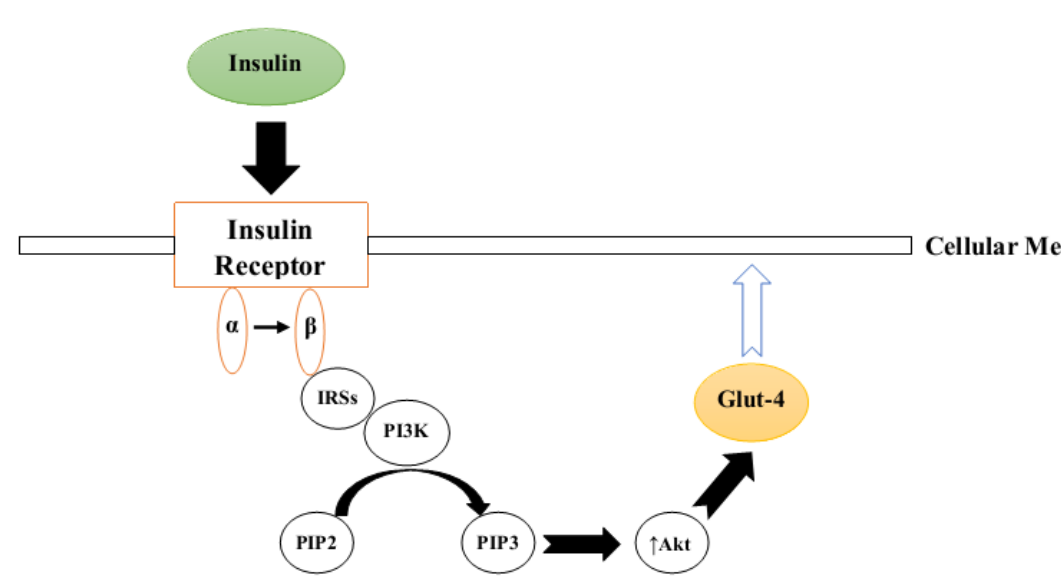
Figure 1: Simplified schematic representation of the insulin signal transduction pathway (IRSs= insulin receptor substrates, PI3K= Phosphoinositide 3-kinase, PIP2= Phosphatidylinositol 4,5-bisphosphate, PIP3= Phosphatidylinositol 3,4,5-trisphosphate, Akt= protein kinase B, Glut-4= glucose transporter type